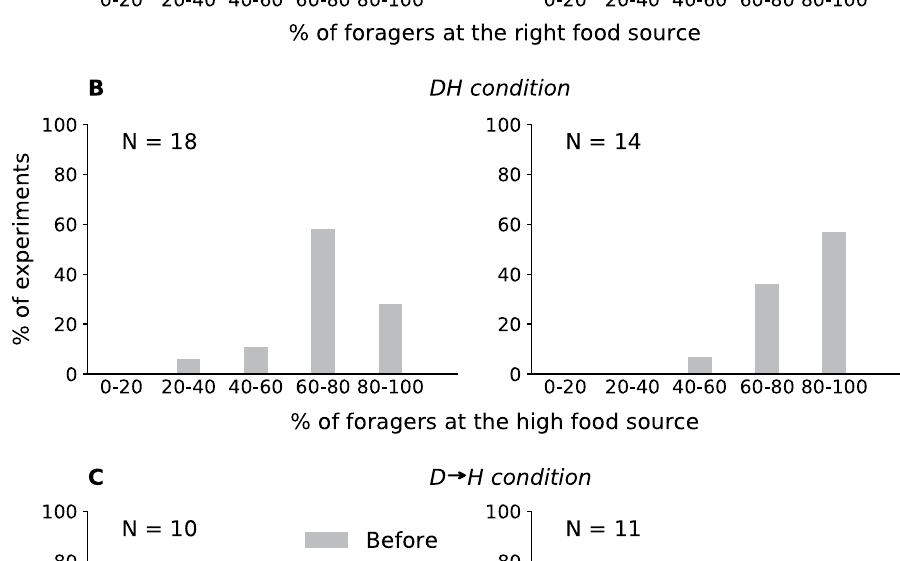
4 Scientific RepoRts | 7: 8745 | DOI:10.1038/s41598-017-08592-9